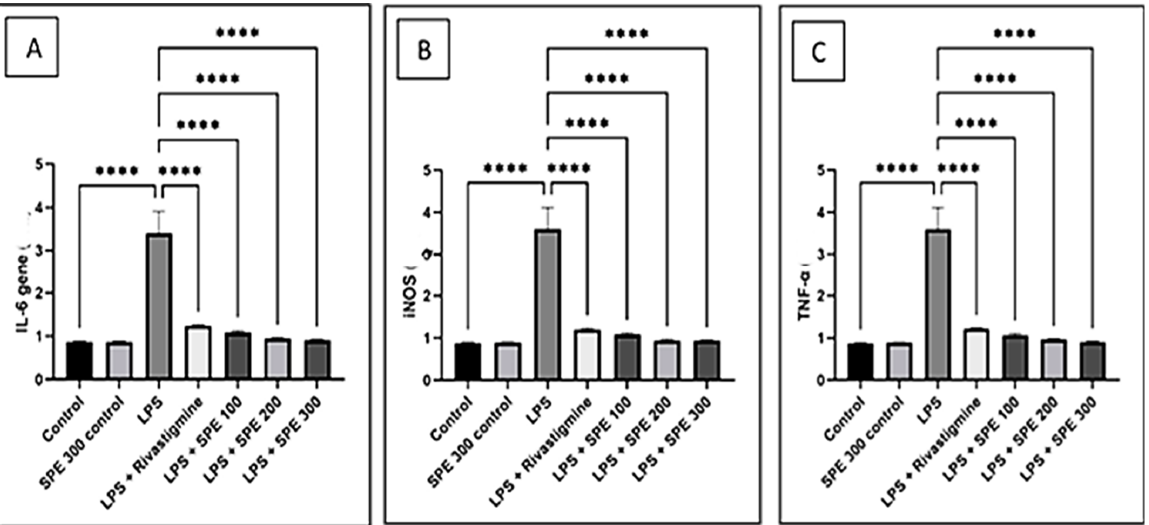
Figure 8. The relative gene expression of ( A ) interleukin-6 (IL-6), ( B ) inducible nitric oxide synthase (iNOS), and ( C ) tumor necrosis factor-alpha (TNF-α) of the control (group 1), SPE 300 control (group 2), LPS (group 3), LPS + Rivastigmine (group 4), LPS + SPE 100 (group 5), LPS + SPE 200 (group 6), and LPS + SPE 300 (group 7). ****: Significant at p ≤ 0.0001.